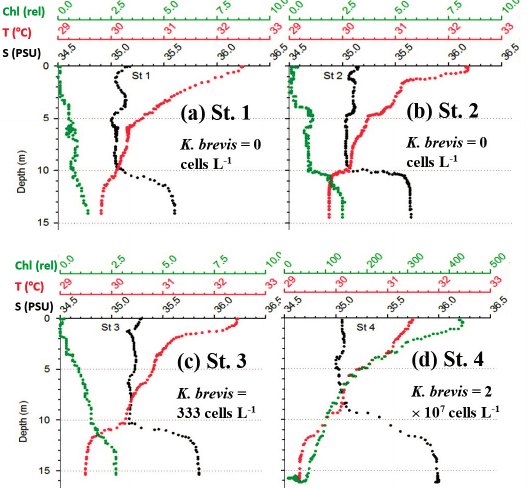
Figure 7. ( a )–( d ): Vertical profiles of salinity, temperature, and Chla fluorescence (relative units) at the four sampling stations shown in Figure 6. Note the dramatic difference in their Chla profiles regardless of the similarity in salinity. K. brevis concentrations of the surface waters are annotated on each panel.